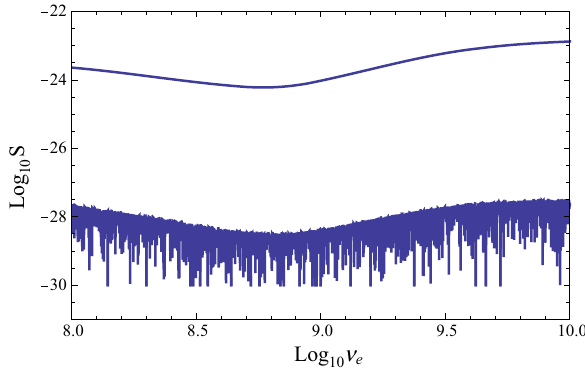
Fig. 5 The ratio of the transverse PPF N 1 x to the BPF N 0 x in the high frequency band, i.e., S = N 1 x | x = 0 . 035m / N 0 x | x = 0 . 035m for RGW and SGWB. The lower curve is the ratio S derived by RGW which is predicted by the canonical single-field slow-roll inflation models. The upper curve is the ratio S derived by the SGWB corresponding to the mergers of black hole binaries with chirp mass M c = 10 − 7 M